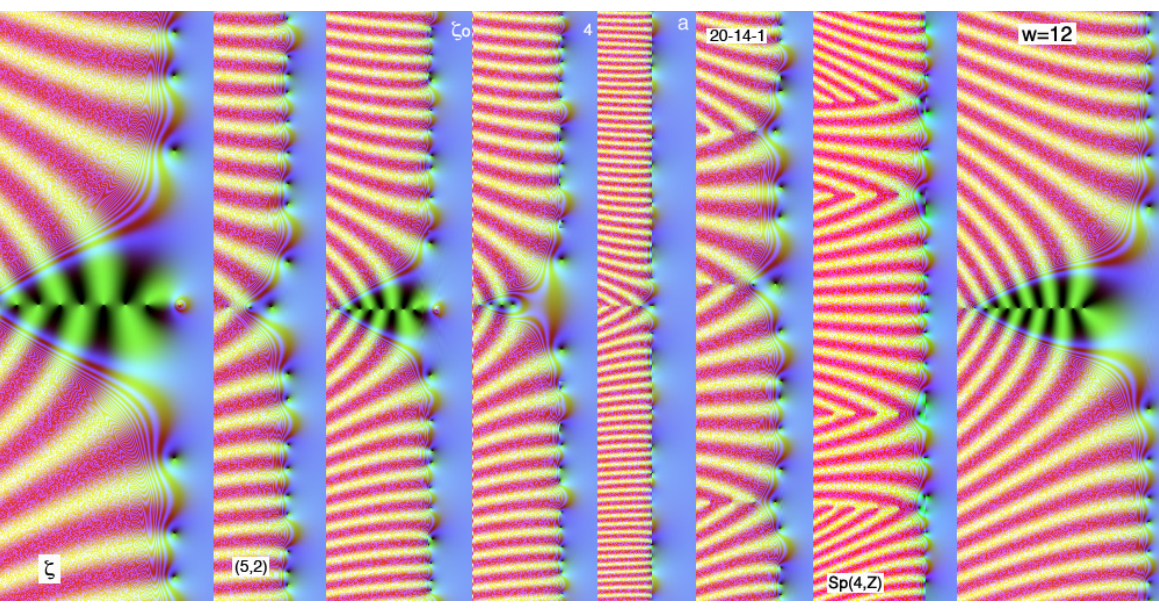
Figure 12: (a) Pattern of di ff erences between successive zeros of zeta in the range from 10 21 for 10 4 successive zeros determined by Andrew Odlyzko shows a Hurst exponent corresponding to a fractal dimension of 1 . 9 with pronounced negative persistence, di ff ering significantly from corresponding statistics of GUE random matrices. (b) The semi-classical potential (dashed line), and the fractal potential (solid line) supporting the first two hundred zeros of ζ ( s ) as energy eigenvalues [23]. Inset is the di ff erence.